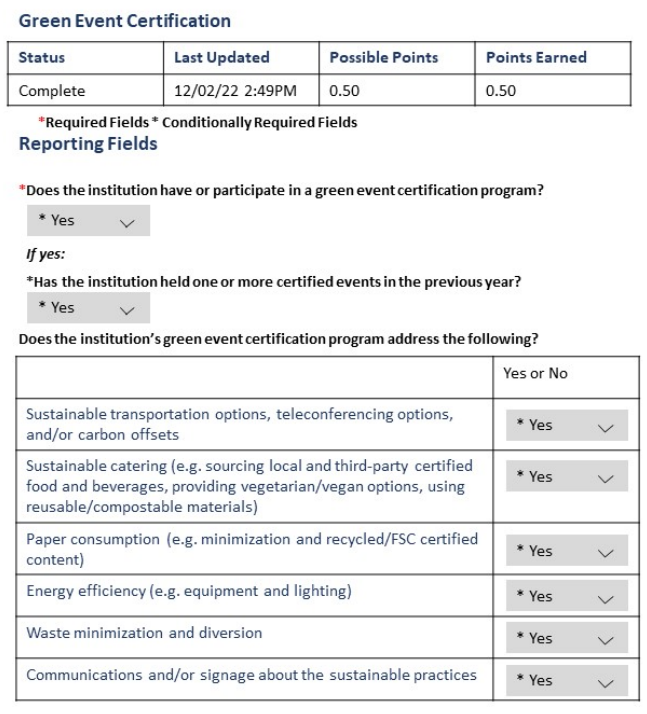
Figure 10. A 2022 STARS IN-18 Green Event Certification Submission.